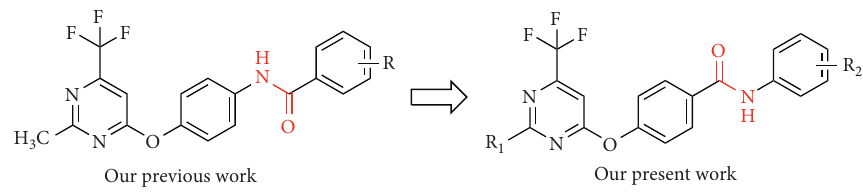
Figure 2: Design route of the target compounds 4a – 4q